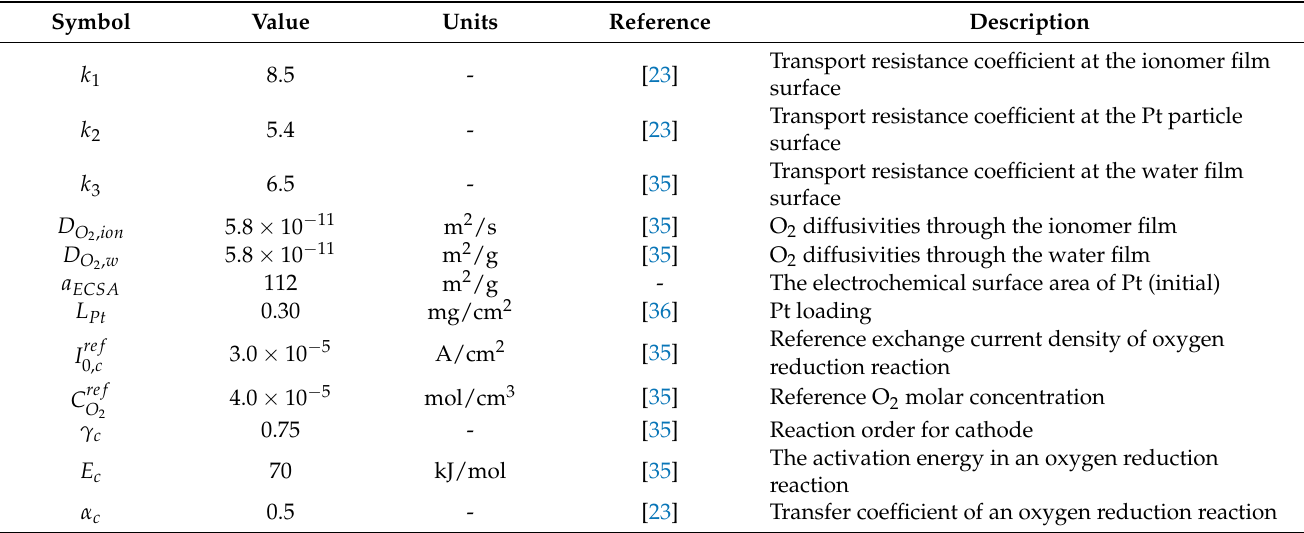
Table 2. Parameter values of the oxygen transport resistance